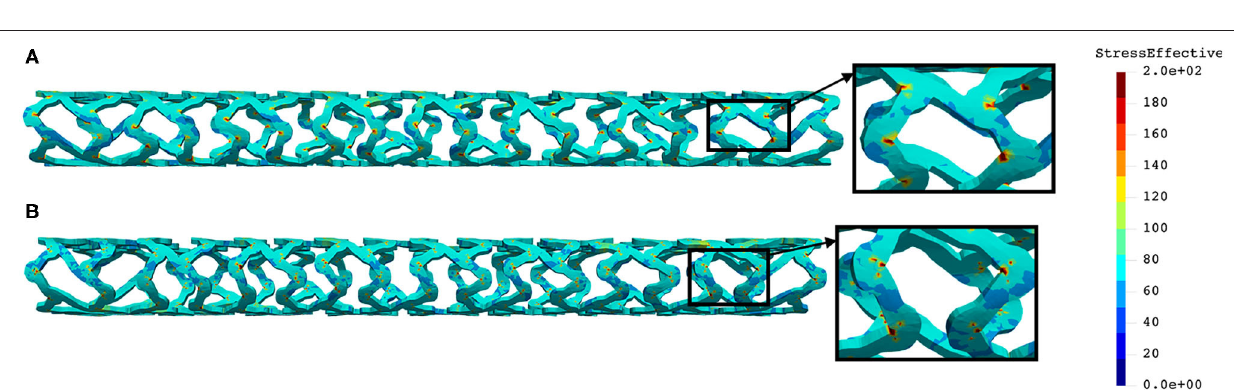
FIGURE 13 | Effective stress distribution on AB-BVS (A) and AB-BVS thinner (B) stents for crush test.